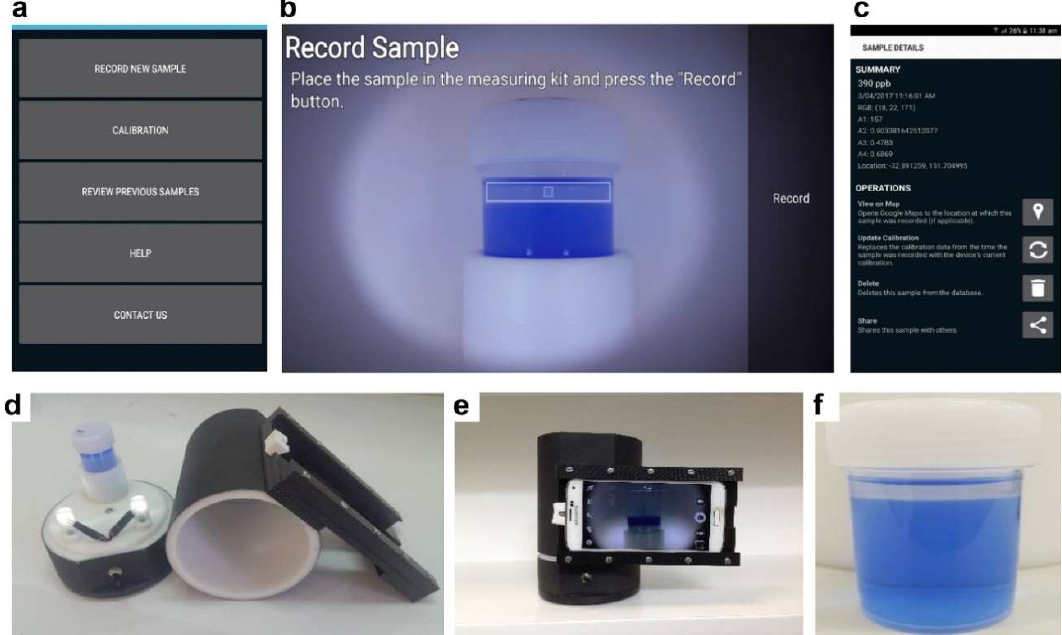
Figure 4. Snapshots ( a – c ) of the app, photos of the reading kit ( d , e ), and sample ( b , f ). In ( b ), the reading screen’s rectangle zone is positioned over the non-aqueous phase layer and the central part (inner square) is the color reading area. In ( d ), two white LEDs are on and a container of 25 mL containing the sample is positioned in a sample holder. In ( e ), the smartphone holder is shown holding a smartphone in the reading position. Note the different orientations (portrait or landscape) of the smartphone in ( a – c , e ). (For interpretation of the references to color in this figure legend, the reader is referred to the web version of this article.). Reproduced with permission from Fang et al. [75].